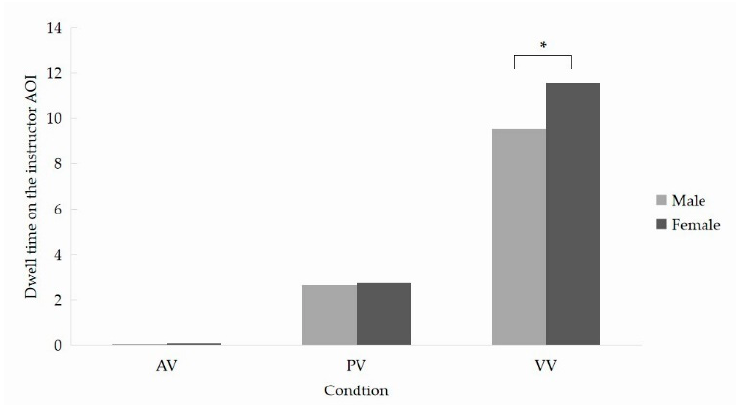
Figure 3. Learners’ dwell time on the instructor AOI. AV, the audio-video condition; PV, the picture- video condition; VV, the video-video condition. * p < 0.05.